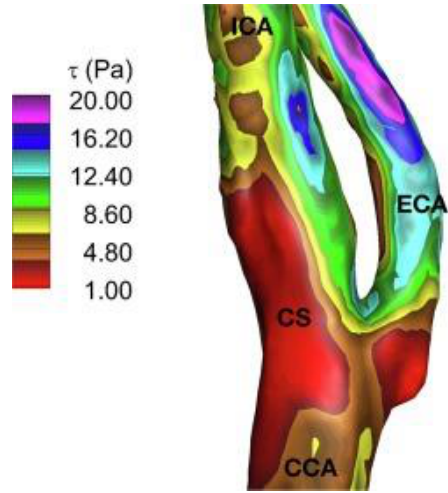
Figure 1. Figure depicting the location of the carotid sinus (CS) in the region of lowest wall shear stress. (ECA = external carotid artery, ICA = internal carotid artery, CC = common carotid artery.